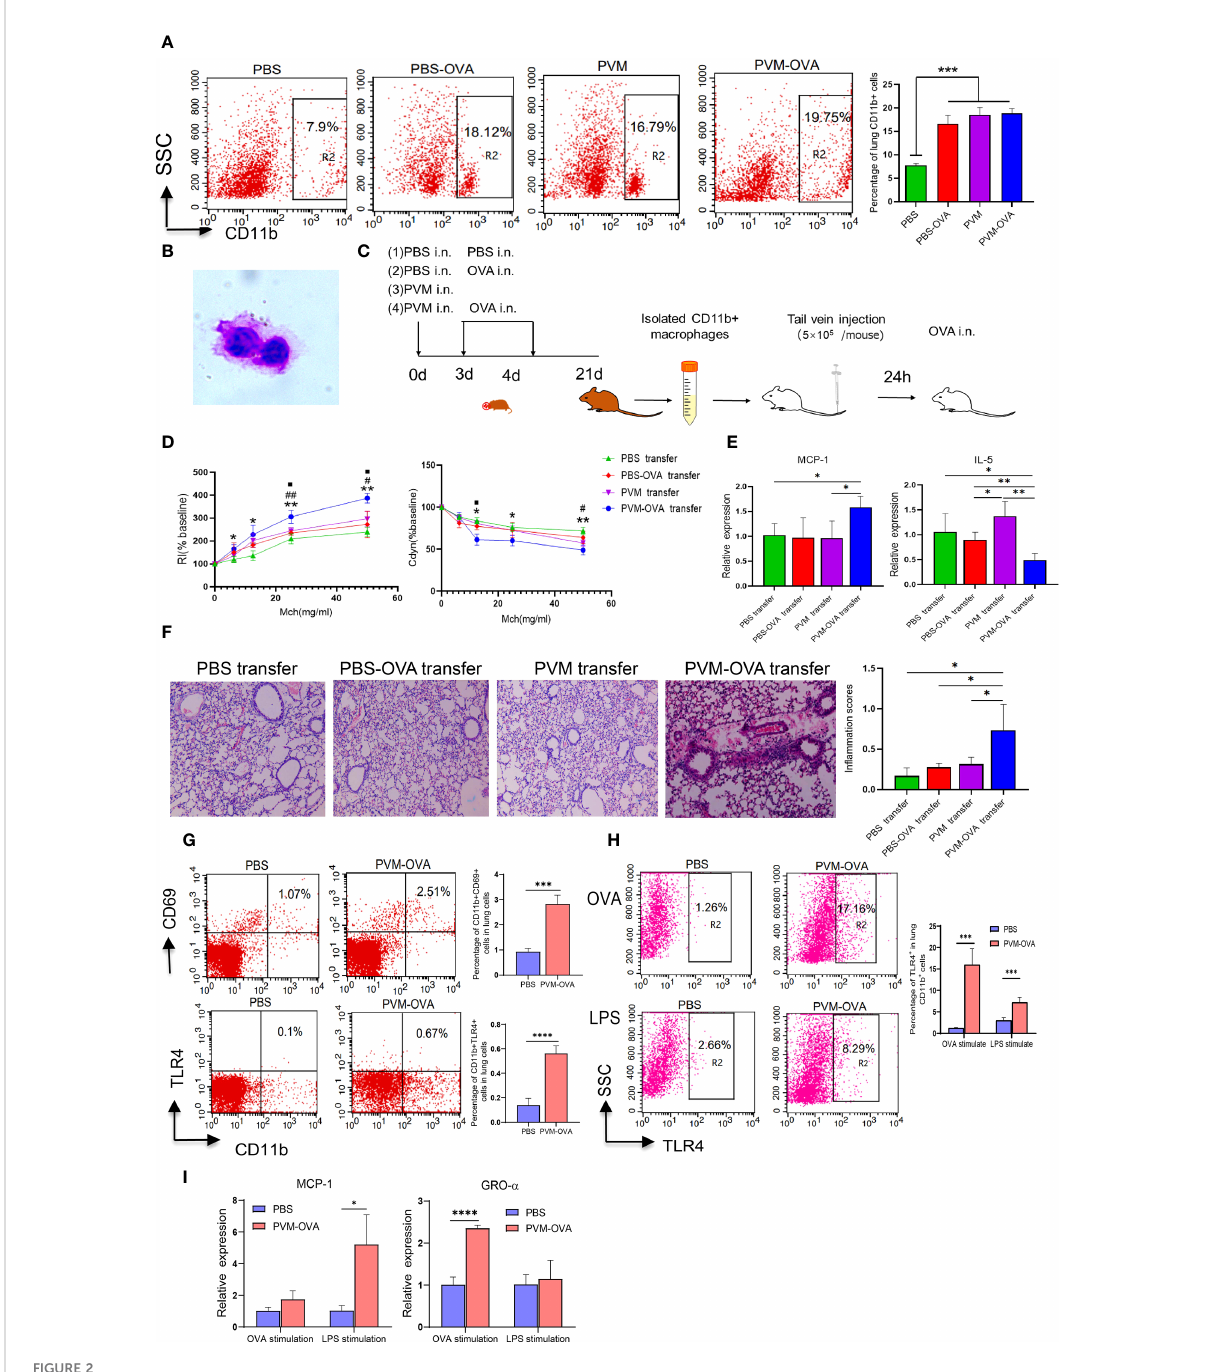
FIGURE 2 Lung CD11b + trained macrophages increased after PVM-OVA early sensitization and mediated asthma in childhood mice. (A) The lung CD11b + cells in the memory phase after sensitization by fl ow cytometry. (B) Lung CD11b + macrophages morphologic evaluation. (C) Timeline of mouse adoptive transfer experiment. (1) PBS transfer group, (2) PBS-OVA transfer group, (3) PVM transfer Group, (4) PVM-OVA transfer group. (D) RI and lung Cdyn in mice after adoptive transfer of the lung CD11b + macrophages following OVA challenge. PVM-OVA transfer group compared with PBS transfer group, *, with PBS-OVA transfer group, #, with PVM transfer group, <. (E) Relative expression of MCP-1 and IL-5 in lung tissue following OVA challenge by Real-time PCR. Each experimental group contained three biology repeats. Data are presented as means standard deviations of 5-6 mice per group. (F) H&E staining of lung tissue slices after adoptive transfer the lung CD11b + macrophages (100X) and in fl ammation scores following OVA challenge. (G) CD11b + CD69 + macrophages or CD11b + TLR4 + macrophages in lungs by fl ow cytometry. (H) TLR4 expression of the sorted CD11b+ macrophages after LPS or OVA stimulation by fl ow cytometry. (I) Relative mRNA expression of chemokines MCP-1 or GRO- a of the sorted CD11b + macrophages after LPS or OVA stimulation by real-time PCR. *P<0.05. ** P<0.01, ***P<0.001, **** P<0.001. ## means PVM-OVA transfer group compared with PBS-OVA transfer group (P<0.01). The symbol “ ■ ” but not “ < ” means PVM-OVA transfer group compared with PVM transfer group